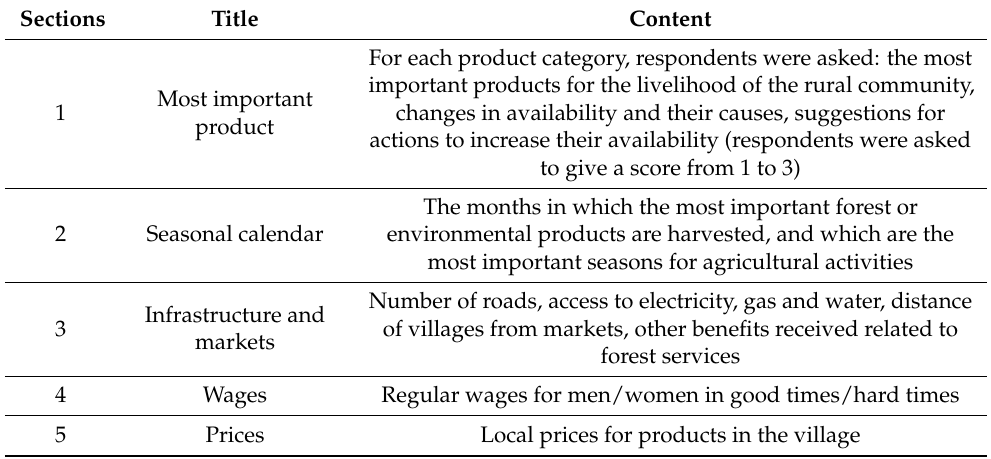
Table 2. Sections and content of the additional questionnaire 2 for representative persons (based on